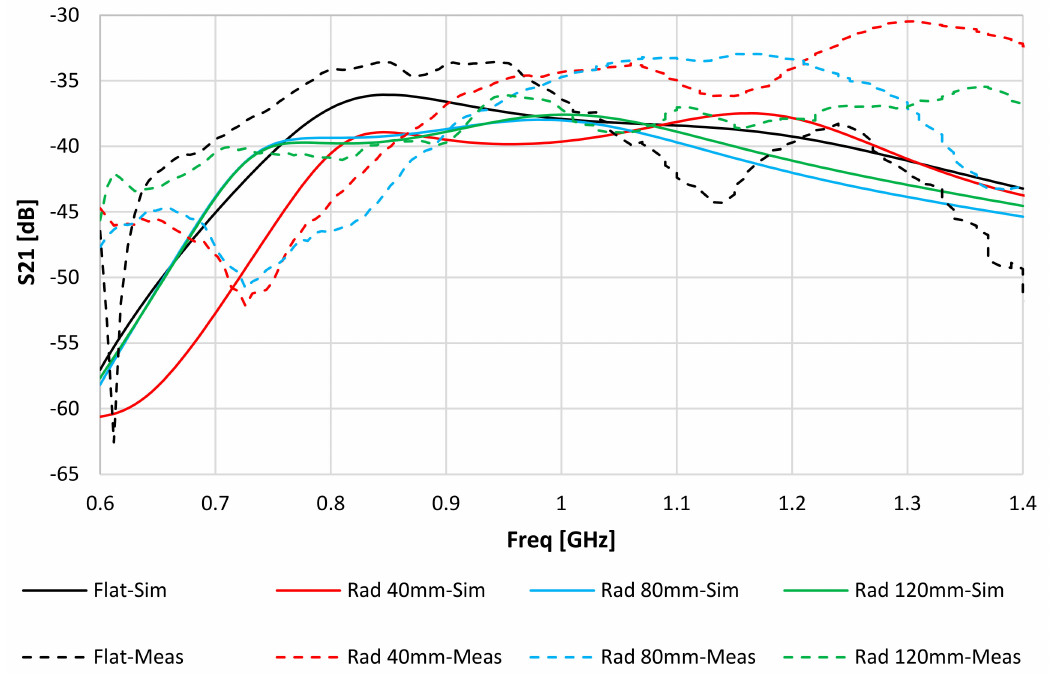
Figure 8. Simulated and measured transmission coe ffi cient (S 21 ) for flat and three bending cases (Kapton thickness of 0.15